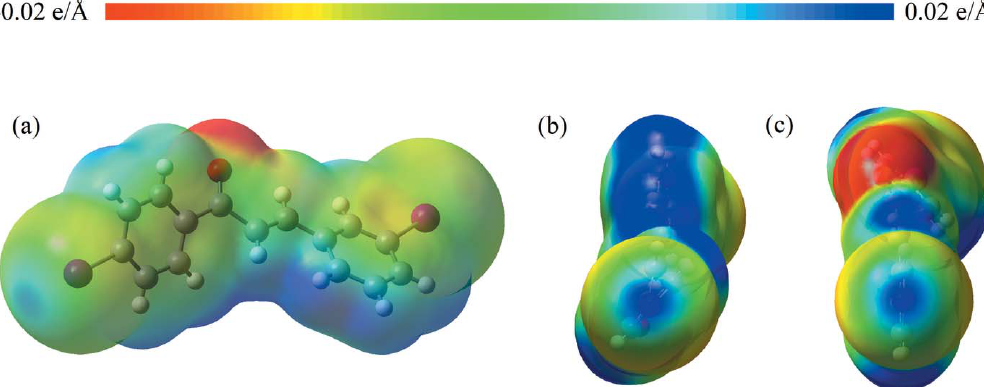
Figure 2 Electrostatic potential mapped onto an electron density isosurface with isovalue 0.02 e A˚ (cid:5) 3 , calculated using B3LYP at the LANL2DZ level. Red and blue regions show negative and positive electric potentials, respectively. ( a ) shows the potential of the substituted chalcone molecule. ( b ) and ( c ) show the (cid:2) -holes on 1-Ring and 3-Ring,